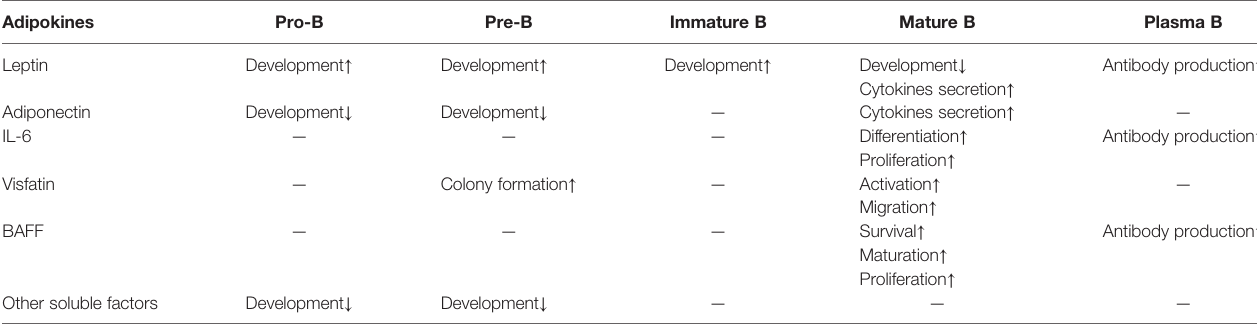
TABLE 2 | The effects of adipokines on B lymphocytes. Adipokines